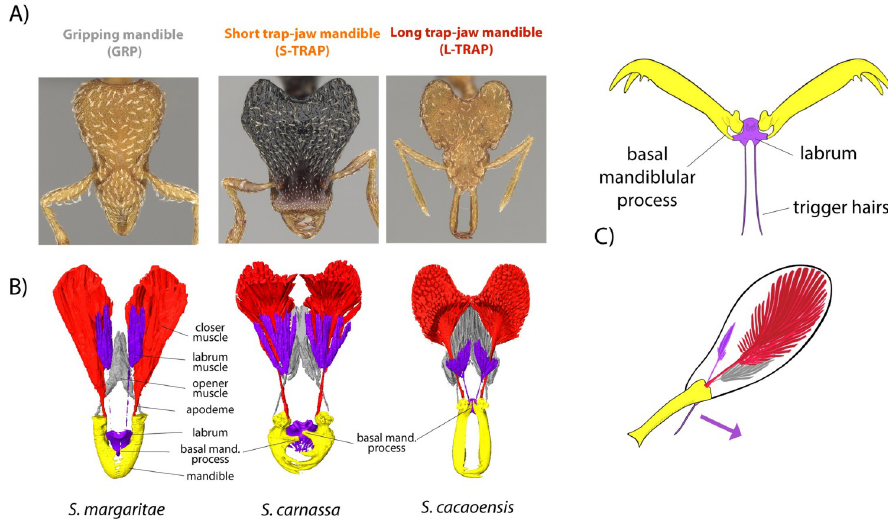
Fig 2. Mandible diversity and trap-mechanism of Strumigenys ants. Strumigenys is a pantropical, hyperdiverse genus of leaf litter predators. (A) Many species have normal mandibles which they use to grip and hold their prey. Some species have power-amplified “trap-jaw” mandibles which they use to strike and stun prey, which comes in short-mandibled (S-TRAP) and long-mandibled (L-TRAP) forms. (B) The trap-jaw mechanism (seen here in a segmented X-ray micro-CT image) involves the modification of the labrum and basal mandibular process into a latch which locks the mandibles in an open position, with labrum muscle triggering release and mandible closure. The trap mechanism is associated with the reorganization of the muscle fibers, a transition from fast to slow muscle fiber orientation, and other changes to the head design (described further in S1 Text). (C) With trap-jaw mandibles in the locked position, the labrum and basal mandibular processes form a latch mechanism, controlled by rotation of the labrum in the sagittal plane.